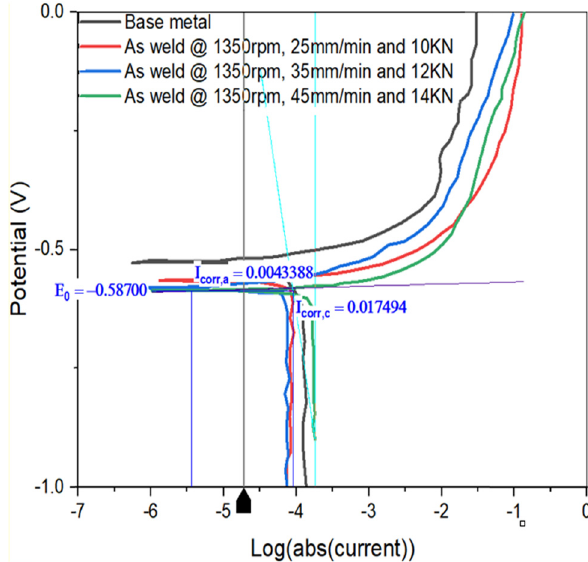
Table 3: CR of di ff erent